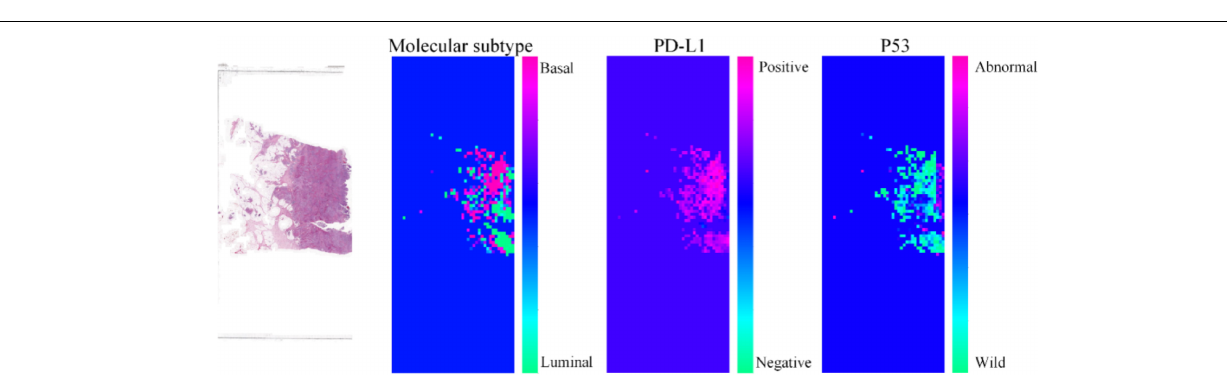
(Dice score: 0.947, pixel accuracy: 0.952, and Jaccard